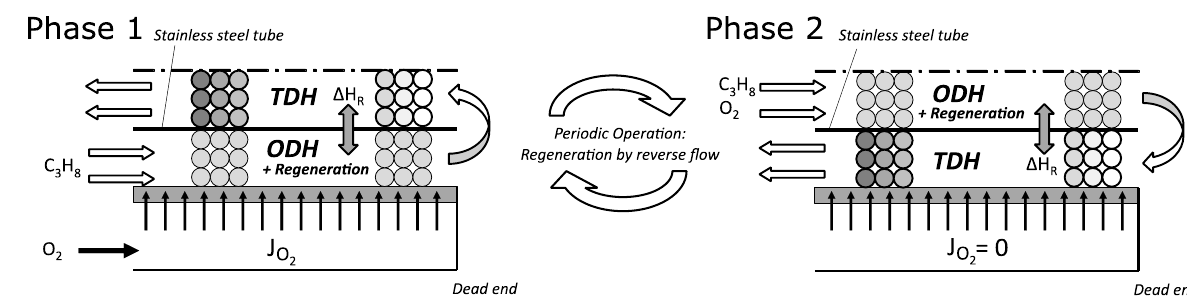
Figure 13. Periodic switch of the flow direction of the PBMRint for a simultaneous production and regeneration.